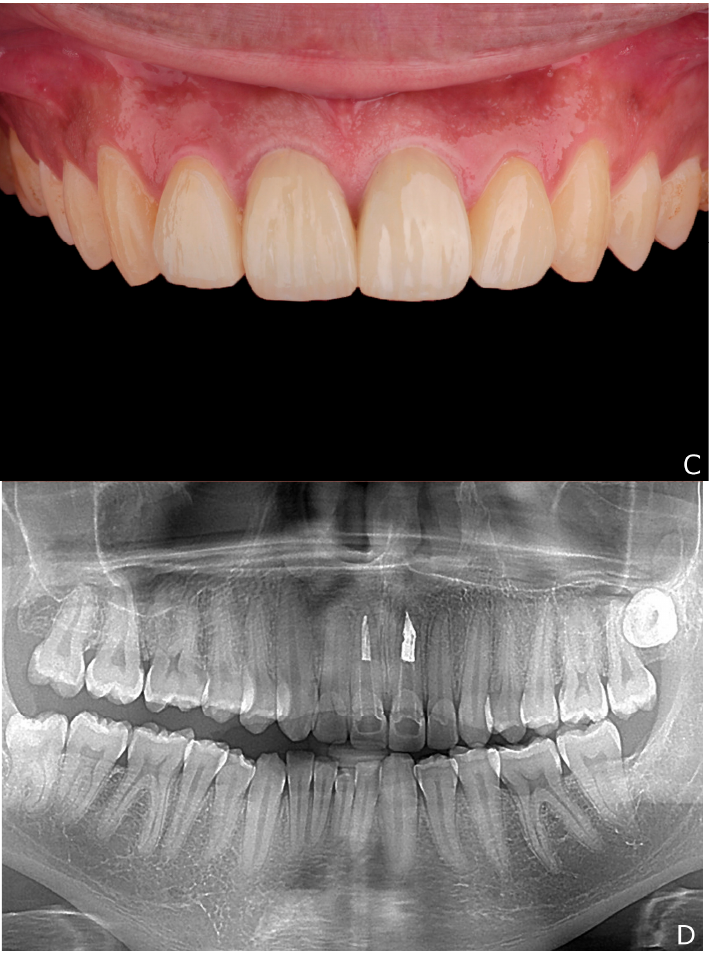
Figure 8. ( A , B ) final situation 48 h after cementation; ( C ) clinical and ( D ), radiographic examination after 60 months of clinical service.